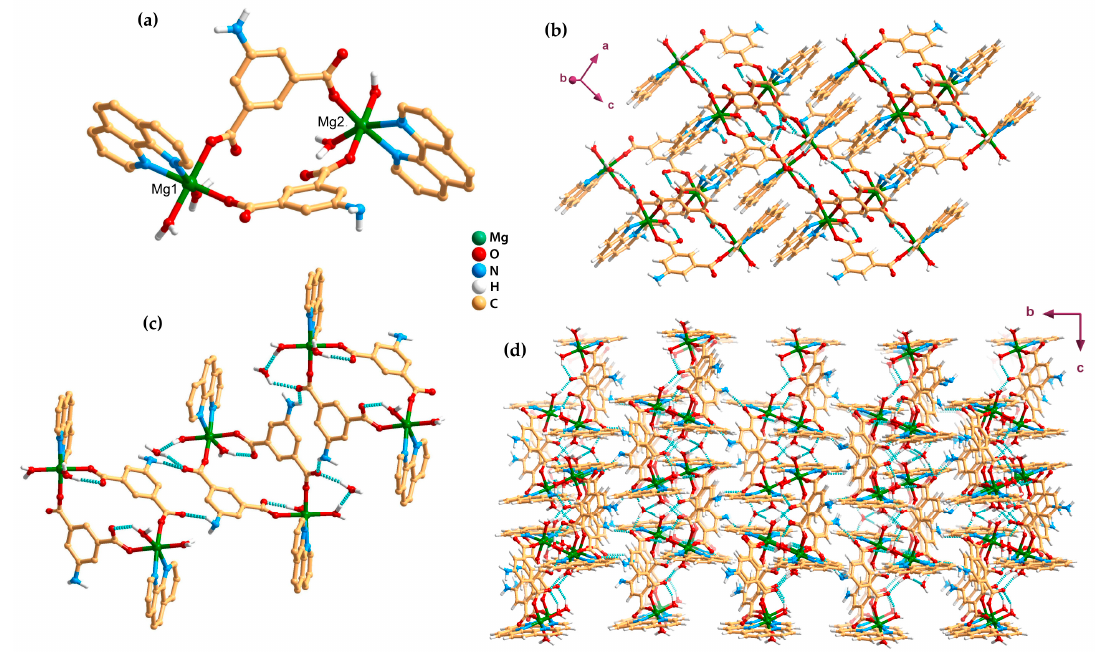
Figure 2. ( a ) Complex 2 , [Mg 2 (aip) 2 (phen) 2 (H 2 O) 4 ] 2 · 2(H 2 O), with the labeling scheme for the two independent Mg 2+ coordination centers (geometric details about the Mg 2+ coordination centers are listed in Table S1); Additional structural features of the crystal structure of 2: ( b ) Partial packing; ( c ) layered supramolecular arrangement viewed in the [1 1 1] direction of the unit cell; ( d ) 3D supramolecular network viewed in perspective along the a-axis of the unit cell. N − H ··· O and O − H ··· O hydrogen bonds are shown as blue dashed lines.